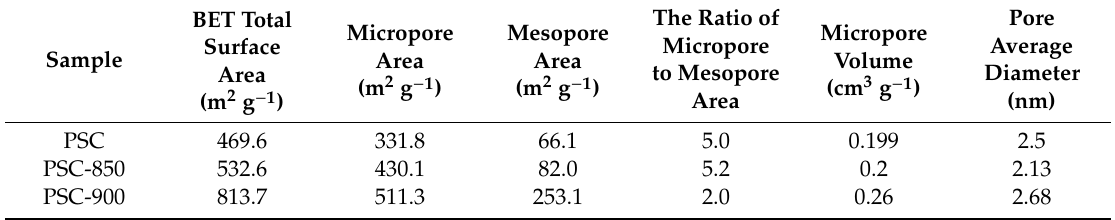
Table 3. The internal structure of PSC and PSCs after 90 min